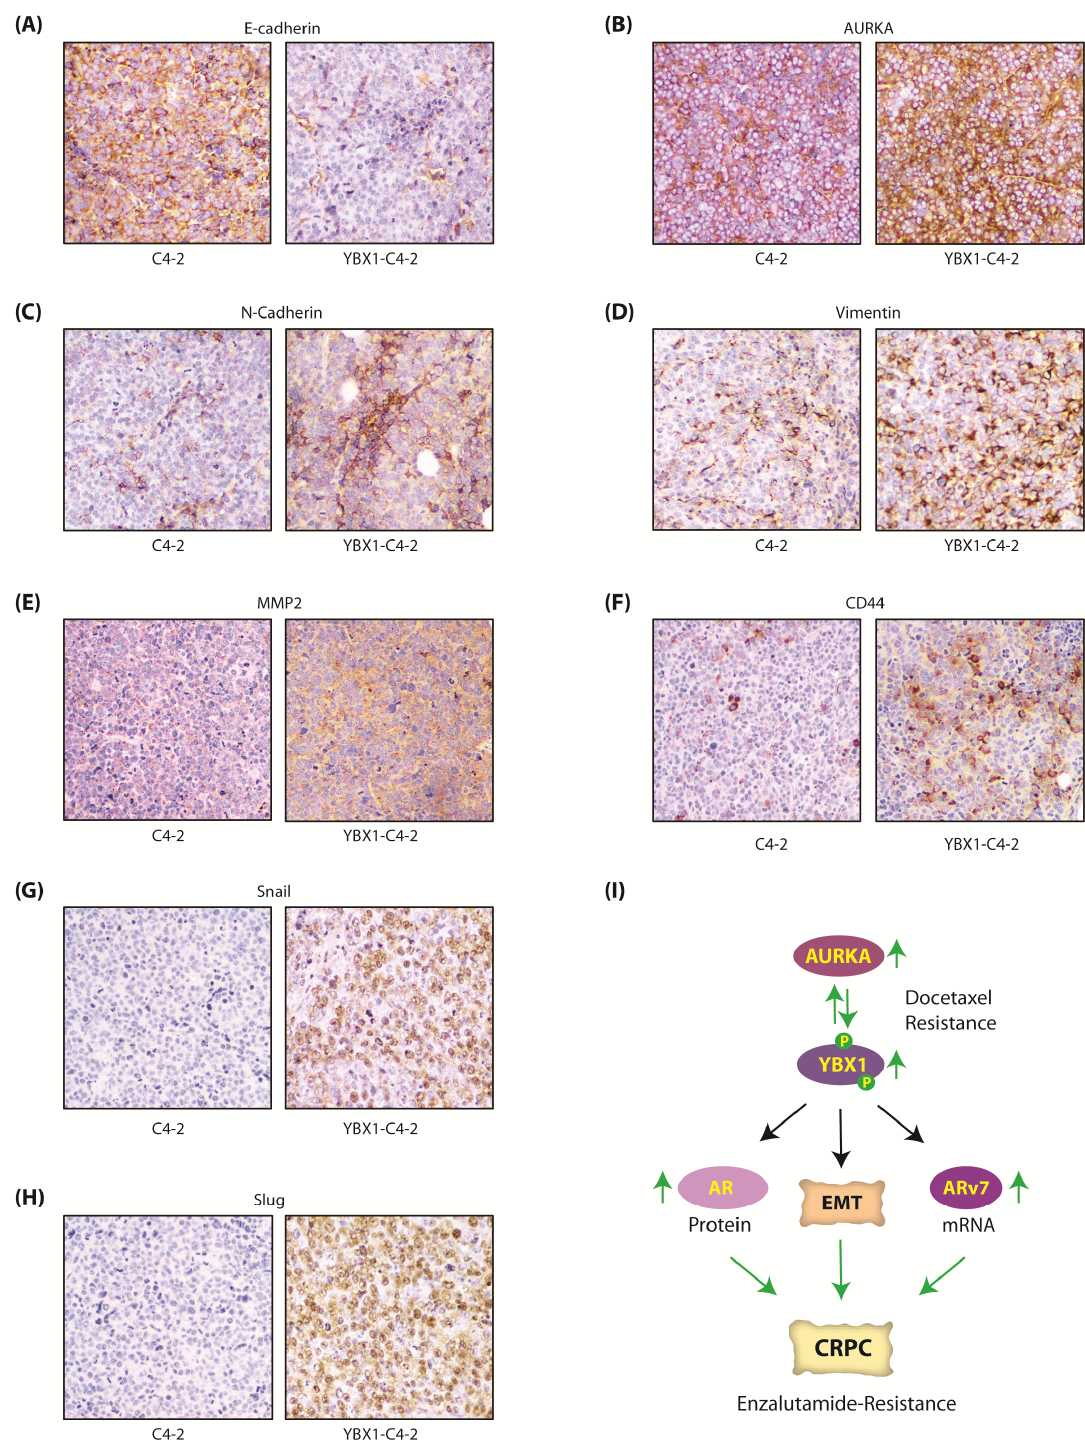
Figure 8. The AURKA-YBX1 feedback loop facilitates EMT in vivo. ( A ) E-Cadherin ( B ) AURKA ( C ) N-Cadherin ( D ) Vimentin ( E ) MMP2 ( F ) CD44 ( G ) Snail and ( H ) Slug proteins in C4-2 and YBX1-C4-2 xenografts as determined by the immunohistochemistry (IHC) assay. ( I ) Proposed model showing the consequences of AURKA-YBX1 synergy in CRPC